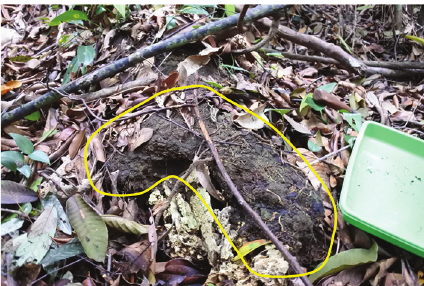
Figure 4: A rebuilt nest of Termes propinquus after being destroyed probably by a mammal, in a diptercarp forest of Suaq Balimbing, North Sumatra (Suaq Balimbing Field Station; colony